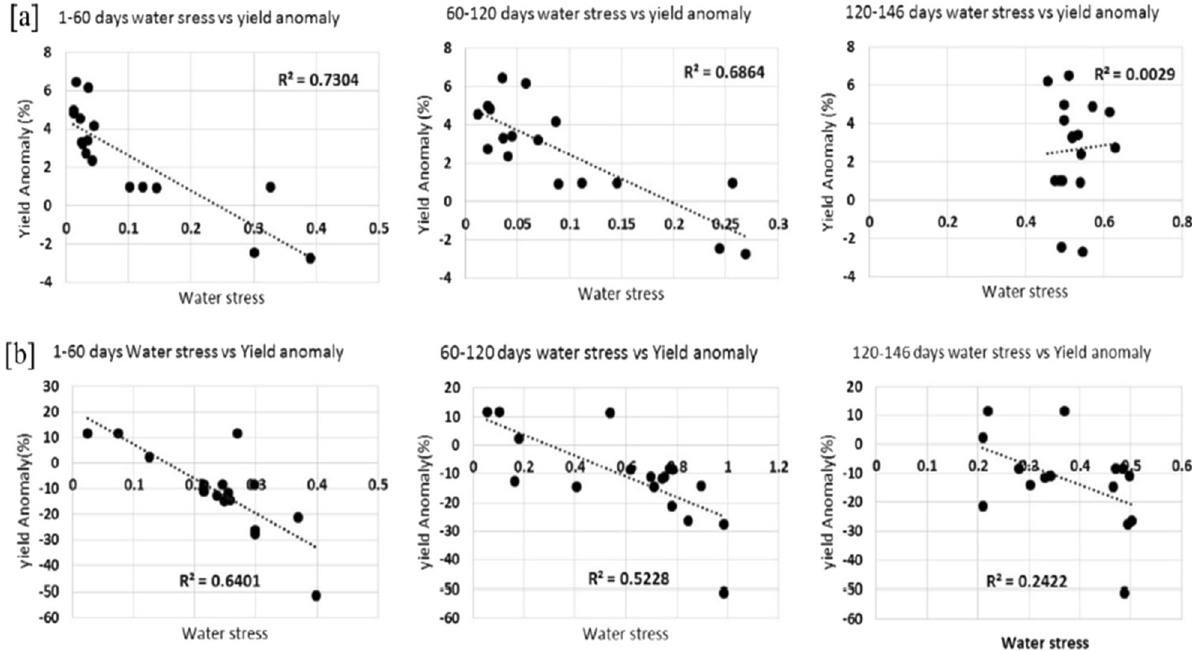
Figure 12. The relationships between annual rice yield anomaly in 2009 and the simulated rice crop water stress factor at the vegetative (1–60 days), reproductive (60–120 days), and maturity (120–146 days) stages throughout ( a ) Punjab and ( b )